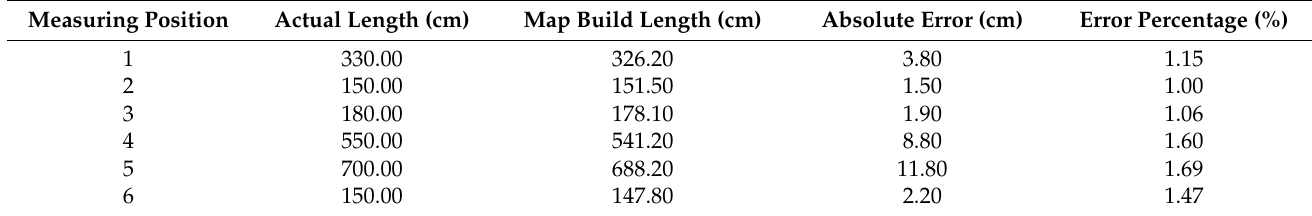
Table 2. Six edge errors of the map constructed by the robot in the experiment.